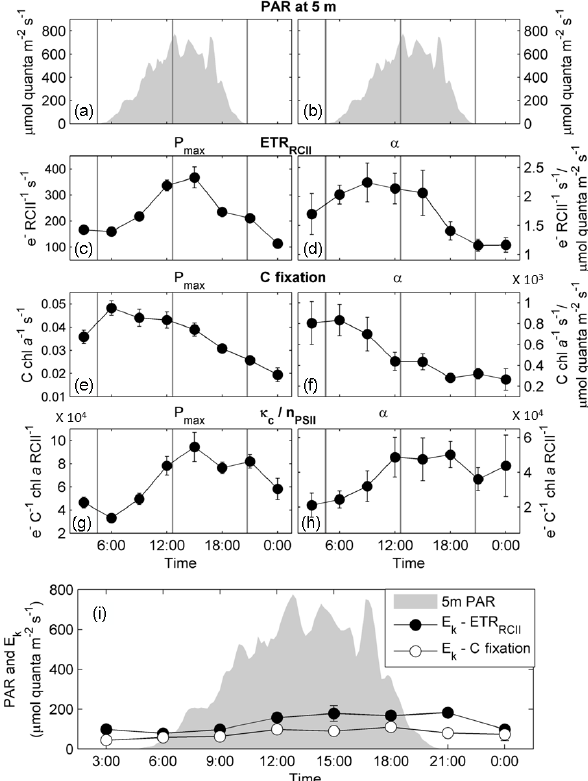
Figure 2. Diurnal changes in capacities and efficiencies of ETR RCII and carbon fixation and the derived conversion factor K c /n PSII . The conversion factor K c /n PSII at light saturation (g) is derived from the values in (c) and (e) . Similarly, the conversion factor K c /n PSII un- der light limiting conditions (h) is derived from values in (d) and (f) . The error in (b) , (c) , (e) , and (f) is the 95% confidence interval of the parameter derived from the fit to data shown in Fig. 1, and the error in (d) and (g) is the propagated error for (b) and (c) and (e) and (f) , respectively. PAR at 5m depth is shown in (a) and (b) . The ver- tical gray lines in panels (a–h) mark sunrise, solar noon, and sunset. Panel (i) shows the light saturation parameter E k for ETR RCII and carbon fixation in relation to in situ light